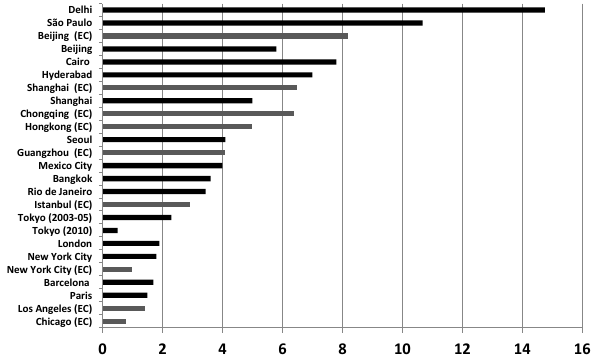
Figure 10. Concentrations of BC (black) and EC (grey) observed in megacities across the world. Note that Bangkok, Barcelona, Chicago, Chongqing, Hyderabad and London have fewer inhabi- tants (Table 1) than the 10 million accepted as a limit for megaci- ties. The uncertainty due to differences in the measurement meth- ods and in the representativeness for urban background conditions is estimated to be approximately 50% (Sect. S3 in the Supplement). References for the studies used here are given in Table